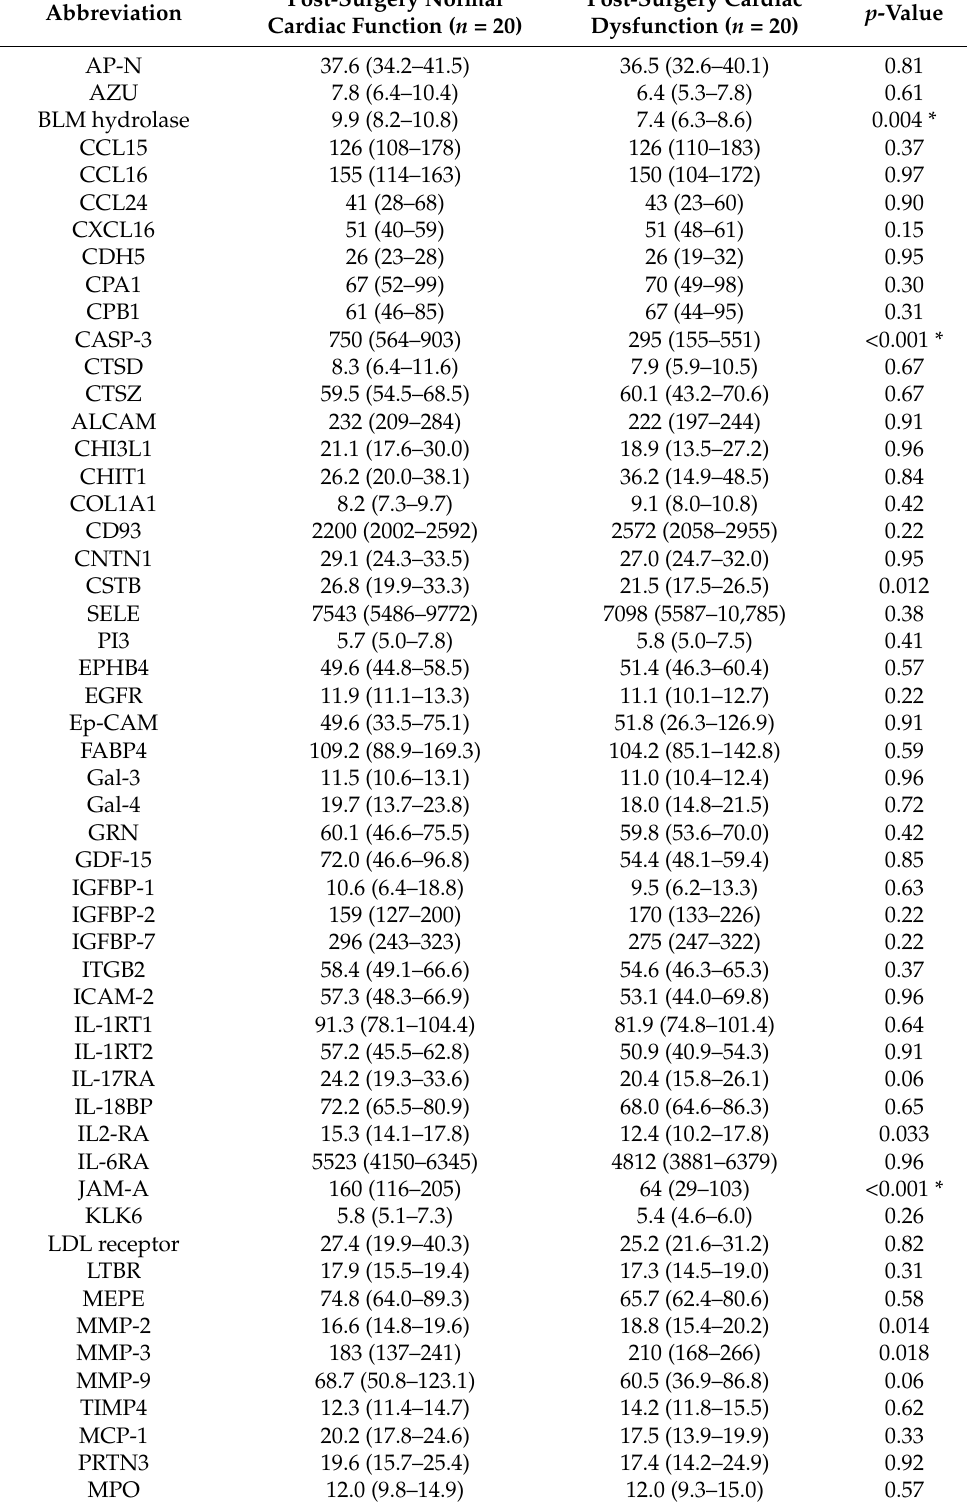
Table 2. Comparison of baseline biomarker values in obesity patients with cardiac dysfunction pre-surgery and normalization of cardiac function one year post-bariatric surgery vs. persistent cardiac